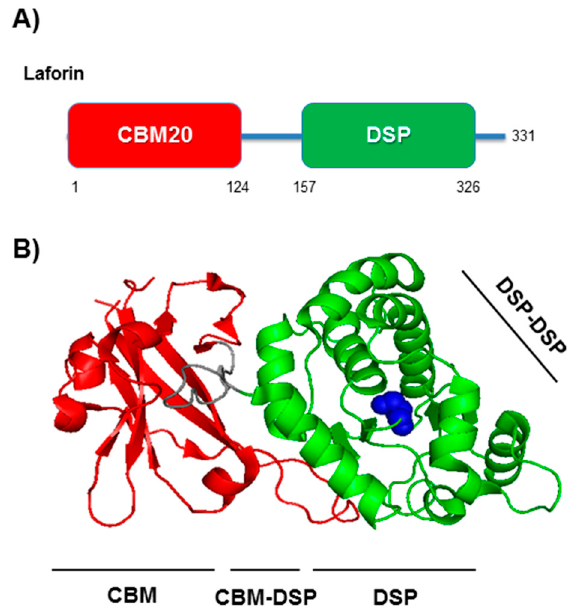
Figure 1. Structural view of laforin. ( A ) Diagram of the different structural domains in laforin; CBM20, carbohydrate binding module type 20; DSP, dual specificity phosphatase domain. Numbers indicate the location of these domains in the laforin protein sequence. ( B ) Crystal structure of a laforin monomer according to Ref. [30]. CBM domain is coloured in red and DSP domain in green. The different regions where the pathogenic mutations cluster are indicated (CBM, CBM-DSP, DSP and DSP-DSP dimerization region). The catalytic Cys residue is coloured in blue.